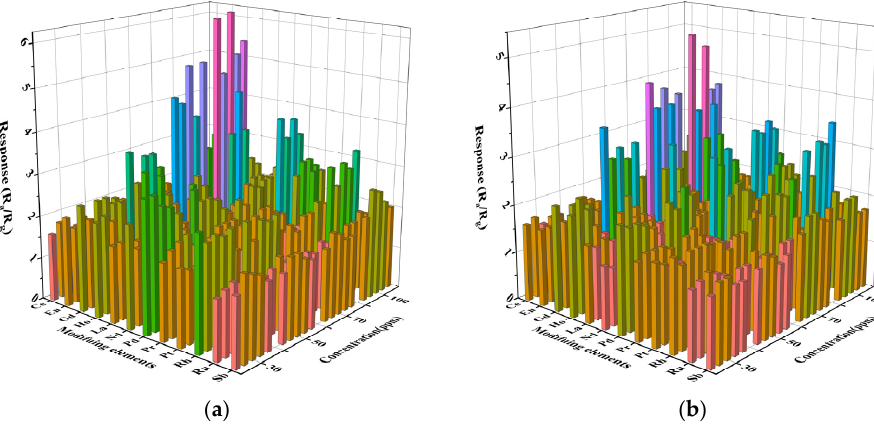
Figure 5. Characteristics of surface-modified In 2 O 3 gas sensor for the determination of volatile compounds in gasoline and diesel at different concentrations at 250 °C. ( a ) Gasoline; ( b ) Diesel.